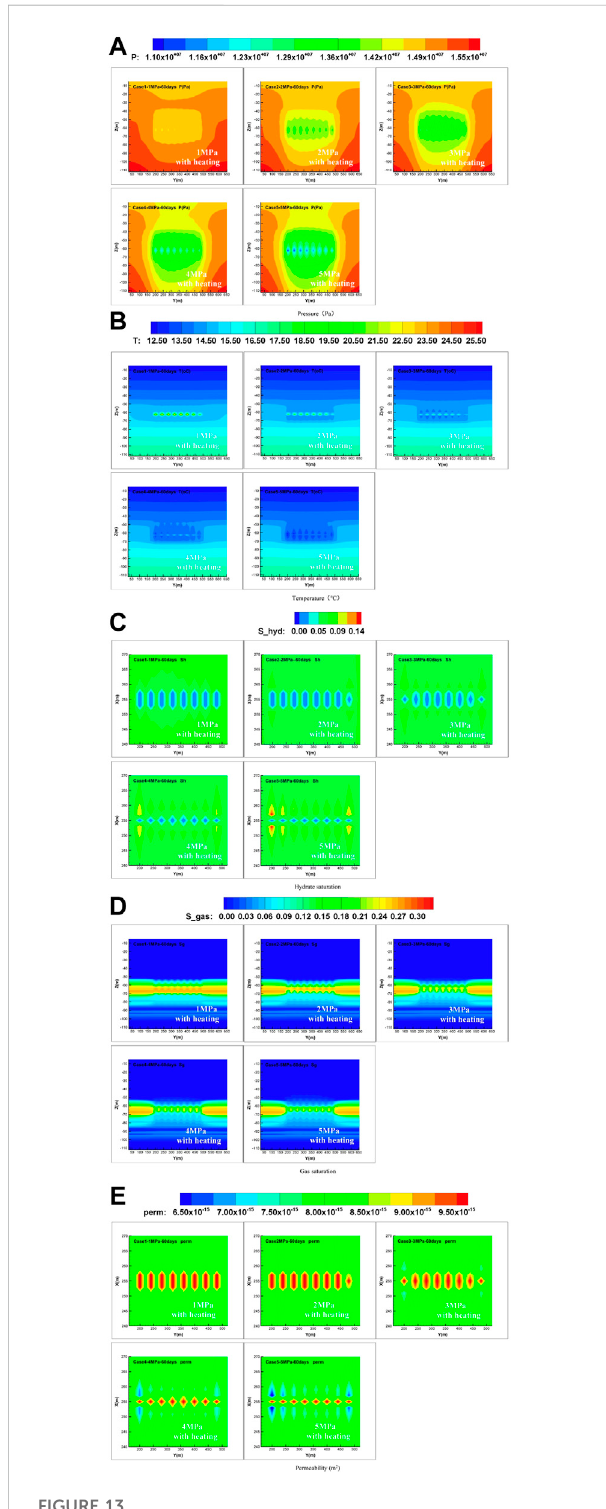
FIGURE 13 Spatial distribution of pressure (A) , temperature (B) , hydrate saturation (C) , gas saturation (D) , and permeability (E) after 60 days of depressurization production with different production system (with wellbore